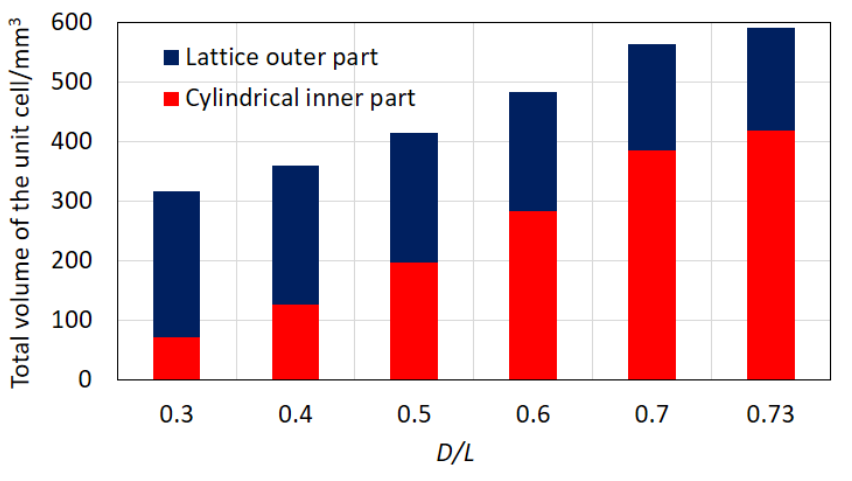
Figure 11. The total volume of the (10 × 10 × 10) mm unit cell by varying the ratio of D / L between 0.3 and 0.73.